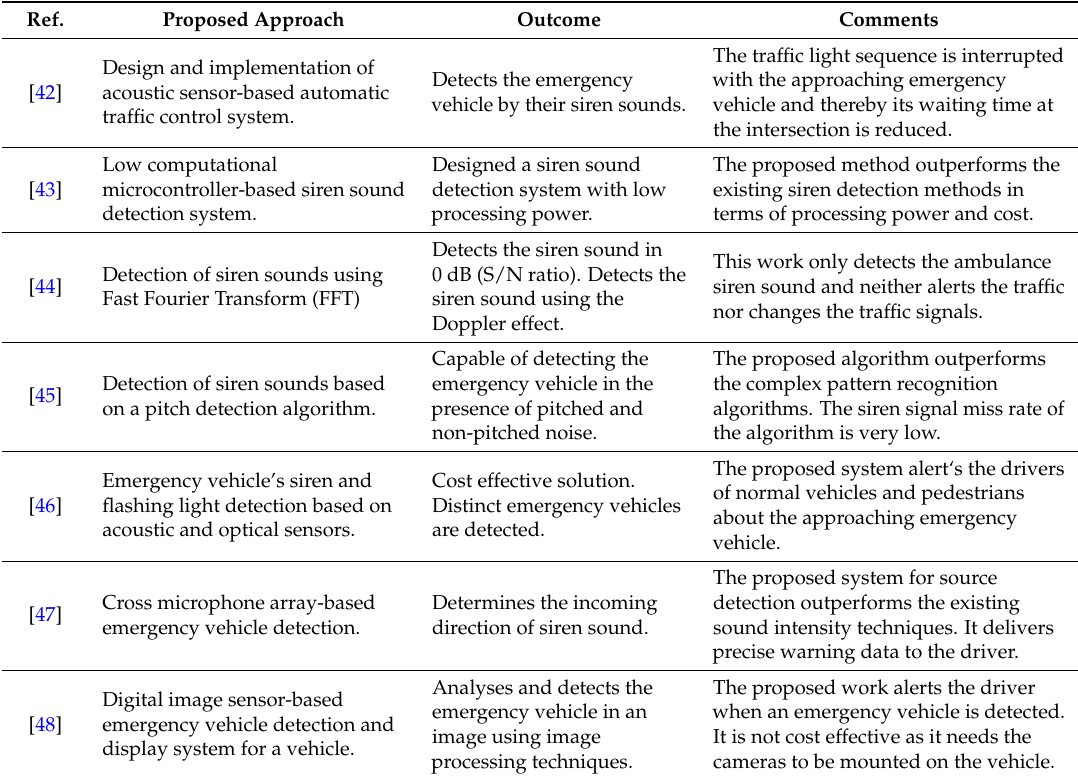
Figure 3. Schematic of a traffic management centre. Table 1. Approaches for emergency vehicle detection based on siren sounds. Ref.